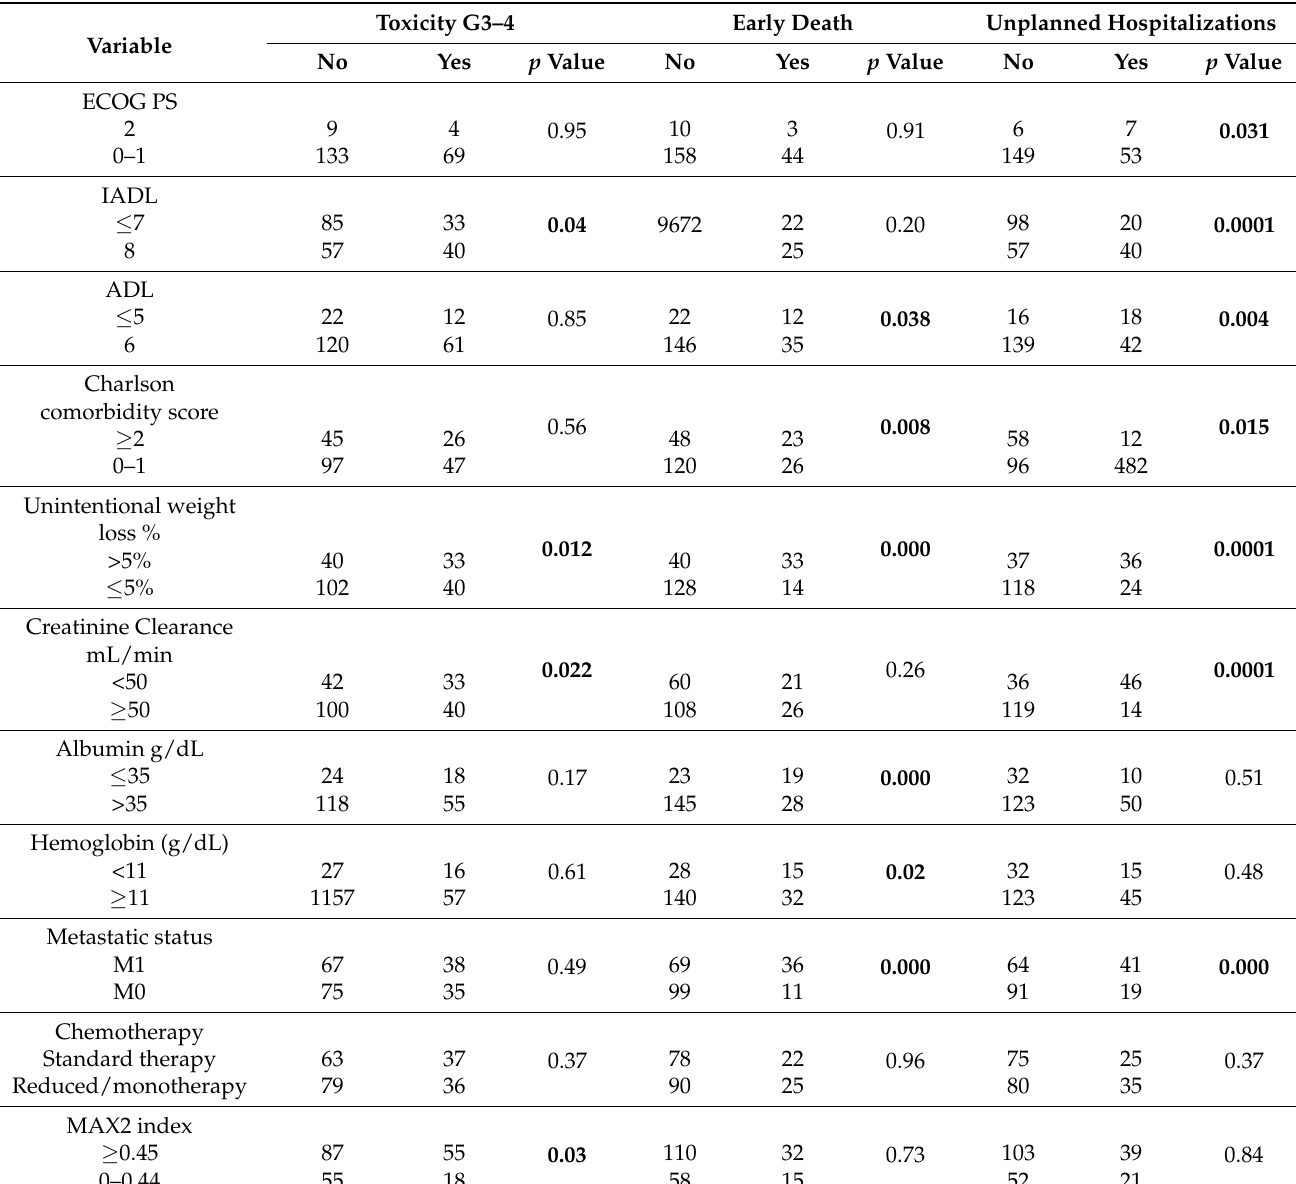
Table 2. Factors associated with toxicity and early death and unplanned hospitalizations.